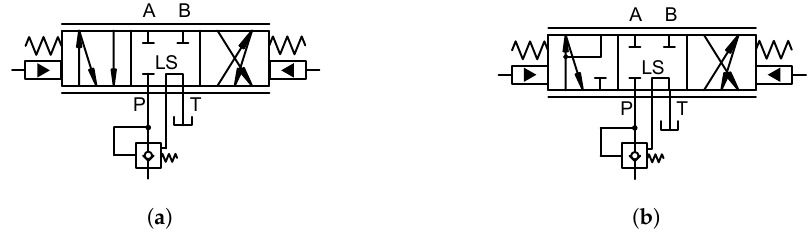
Figure 2. Mobile hydraulic spool valves of the test-bed manipulator: ( a ) Typical mobile hydraulic spool, used with the base, lift and tilt cylinders; and ( b ) differential spool (see position on the left) used with the extension cylinder.